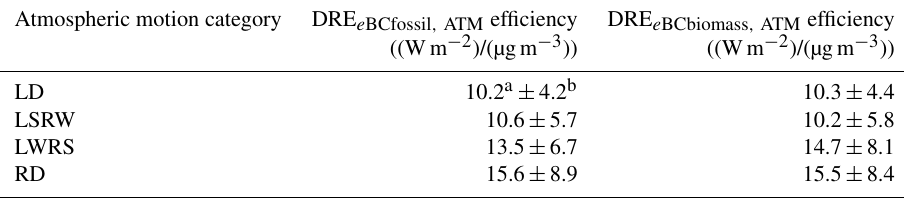
Table 2. Direct radiative forcing efficiencies for equivalent black carbon ( e BC) from fossil fuel combustion ( e BC fossil ) and the e BC from biomass burning ( e BC biomass ) under four atmospheric motion